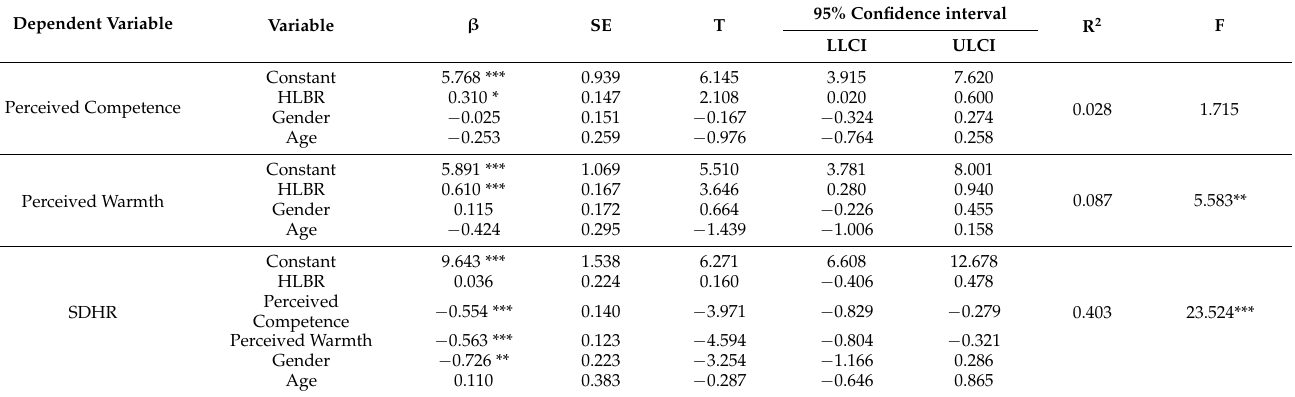
Table 6. Model test of mediation analysis (US).